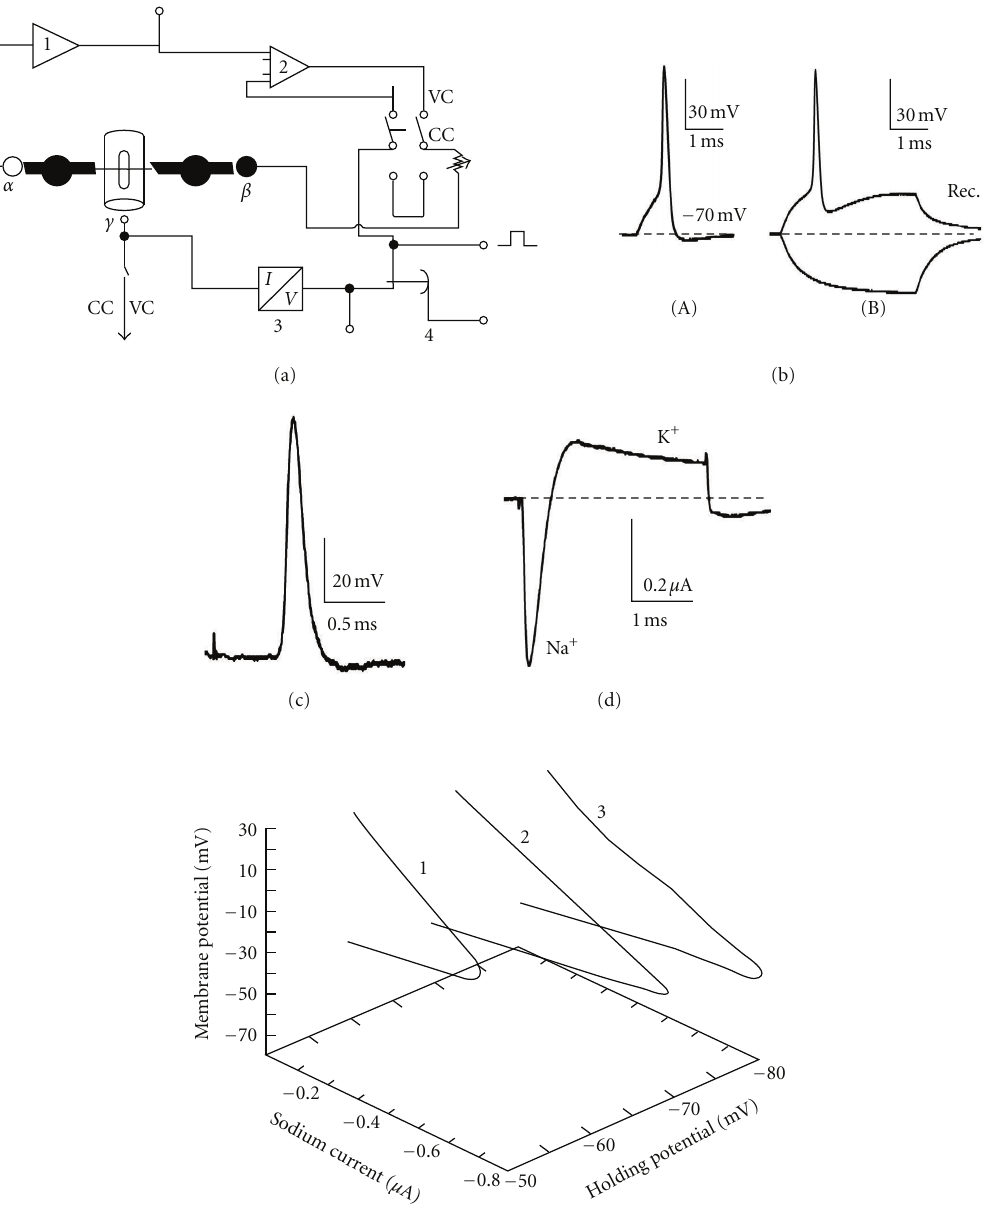
Figure 2: Single-fiber double-oil-gap method on isolated giant axon. (a) Electronic arrangement of technique for current- and voltage- clamp recordings (CC and VC, resp.)—according to [4]. α and β are the lateral (recording and stimulating) electrodes immersed in 180 mM KCl—they have contact with the cut ends of axons in connective and represent intracellular electrodes; γ electrode is plunged in physiological saline (with the tested substances)—it has contact with the extracellular side of the isolated axon. Amplifier 1 is a high-input impedance, negative capacitance amplifier, 2—high-gain di ff erential amplifier, 3—current-to-voltage converter; 4—analogue compensator for leakage and fast and slow capacitive currents. In CC γ electrode is grounded and resistor = 3M Ω . (b)(A) Action potential evoked by a 0.5 ms depolarizing current pulse. (b)(B) The e ff ect of long symmetrical current pulses: the hyperpolarizing one—used to estimate the passive axonal membrane properties and the depolarizing one—used to observe the membrane rectification (Rec.). (c) Action potential recorded from in situ giant axon using microelectrode. (d) Total current recorded under voltage pulse from holding potential − 70 mV to − 10 mV; K + —potassium component, Na + —sodium component. (e) Voltage-dependence of sodium current recorded at various holding potentials: − 1: − 60, 2: − 70 and 3: − 80 mV. The points (not shown) for curves are mean values from 5 experiments performed in control conditions. Note that at holding potential of − 60mV, about 50% of Na current is